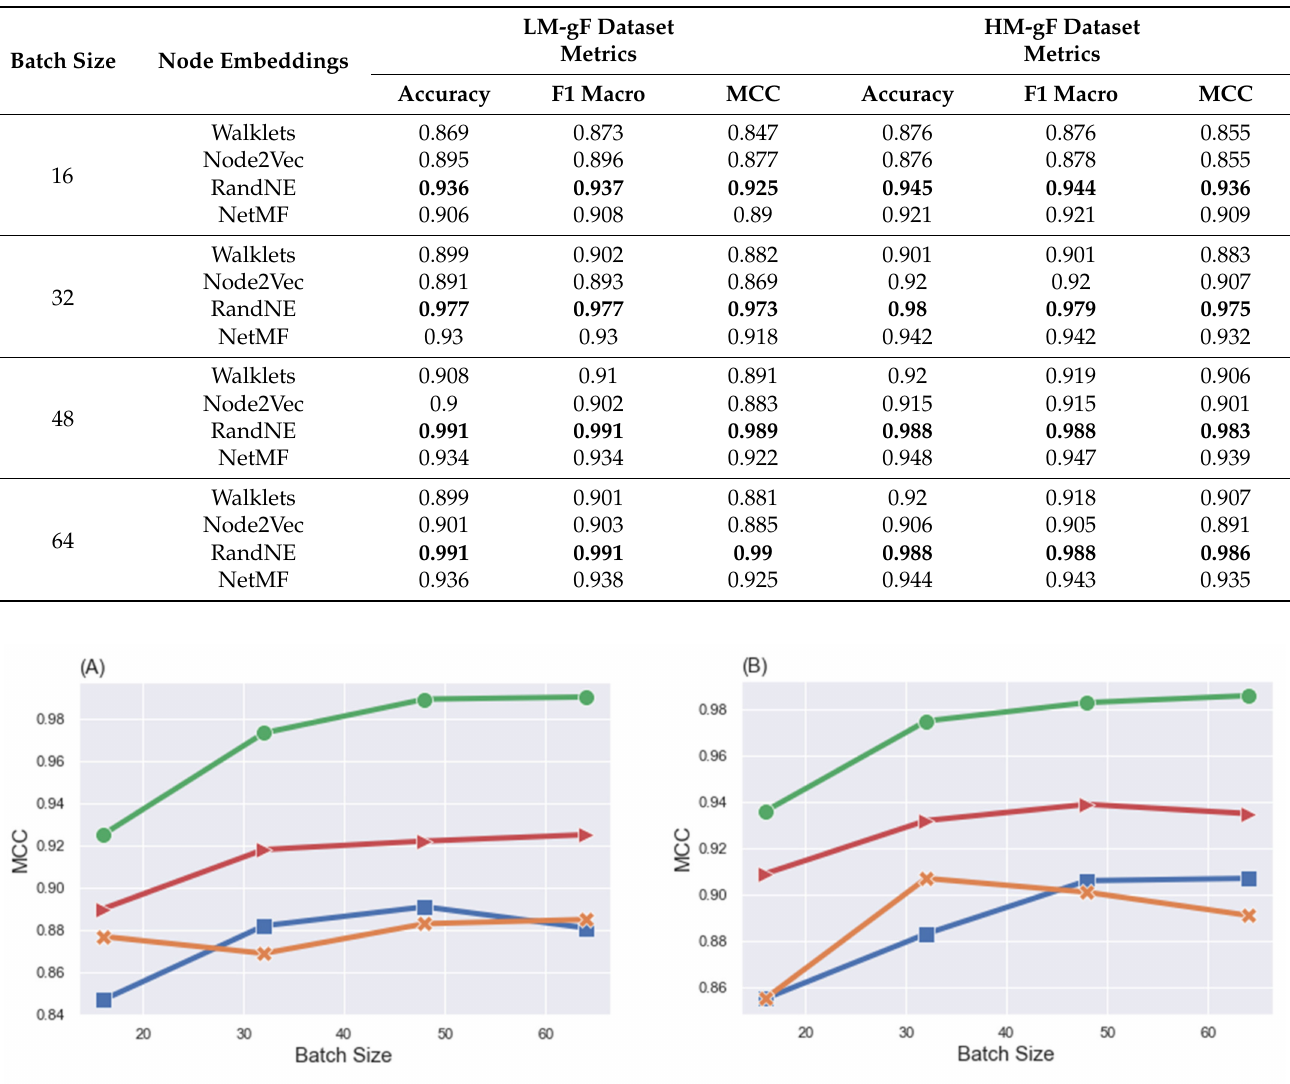
Table 4. Two-factor performance comparisons, taking into account the influence of node embedding methods and batch sizes in the GCN model, by using both LM-gF and HM-gF task fMRI data. Bold values represent the best classification performance obtained for each batch size.